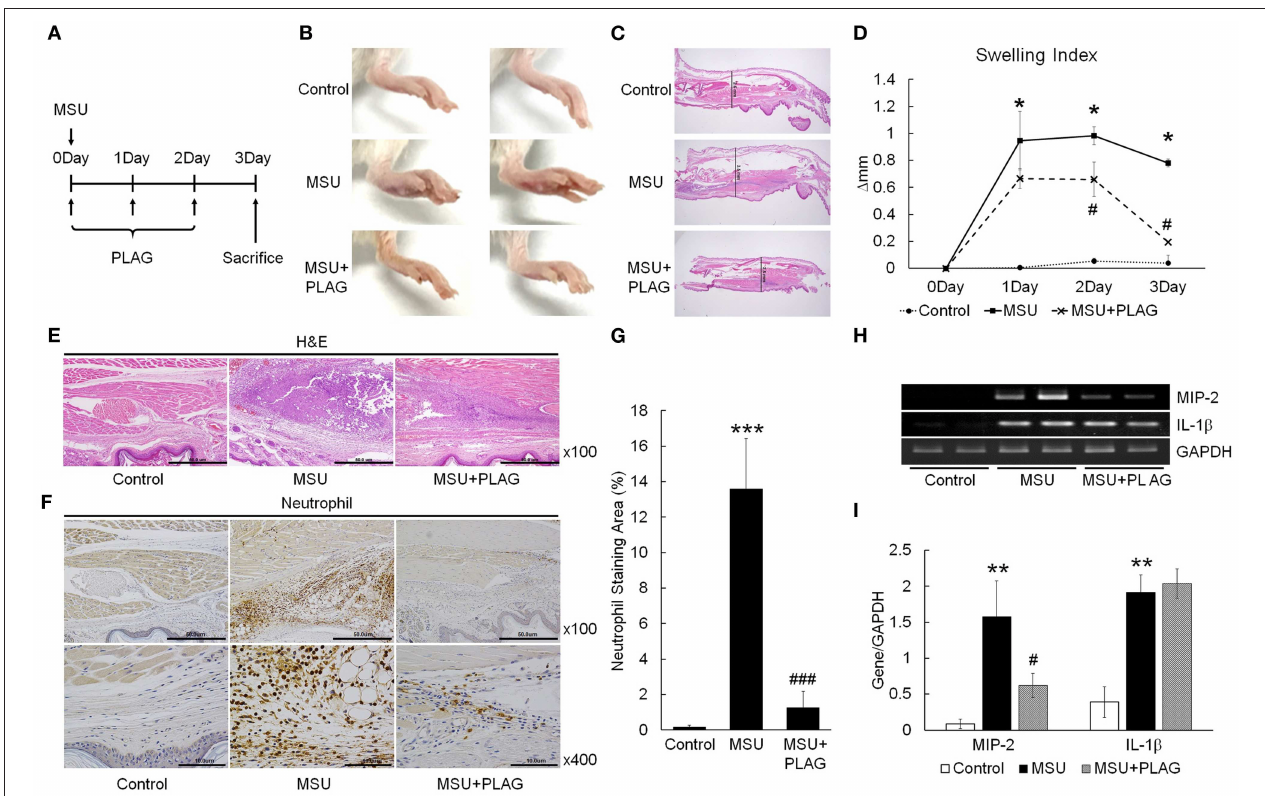
FIGURE 1 | PLAG alleviates MSU-induced gouty inflammation by reducing neutrophil infiltration in gouty lesions. (A) BALB/c mice were divided into three groups: a PBS-treated group, an MSU-treated group, and an MSU/PLAG co-treated group. MSU (1 mg/mouse) was injected into the footpad once on 0 day and PLAG (250 mg/kg) was given via the oral route every day on 0, 1, 2, day. Photographs (B) and Hematoxylin and eosin (HandE)-stained sections (C) represents paw swelling in the MSU crystal only and MSU/PLAG-treated mice. (D) Footpad swelling was calculated for 3 days in the MSU crystal only and MSU/PLAG-treated mice. (E,F) Hematoxylin and eosin stained sections and immunohistochemical staining with anti-neutrophil antibody were performed 3 days after MSU crystal injection. (G) Quantification of the stained neutrophils seen in (F) (% of stained area). (H) Expression of MIP-2 and IL-1 β was analyzed in the footpad tissues using RT-PCR. GAPDH was used as an internal control. (I) Quantification of (H) . Data are presented as mean ± SD. The level of significance was determined by one-way ANOVA. * p < 0.05, ** p < 0.01, *** p < 0.001, compared to the control group. # p < 0.05, ### p < 0.001, compared to the MSU-treated